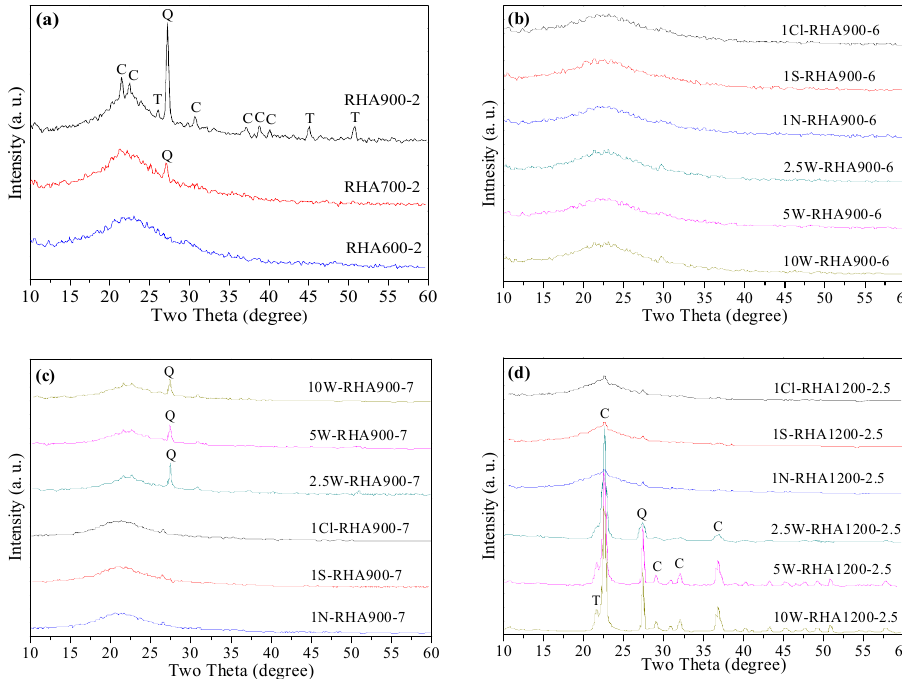
Figure 7. XRD spectra of RHAs obtained from: ( a ) unpretreated RHs burnt out at 600, 700, and 900 °C for 2 h; ( b ) various leaching-pretreated RHs burnt out at 900 °C for 6 h; ( c ) various leaching-pretreated RHs burnt out at 900 °C for 7 h; ( d ) various leaching-pretreated RHs burnt out at 1200 °C for 2.5 h. (C = cristobalite; Q = quartz; T = tridymite).